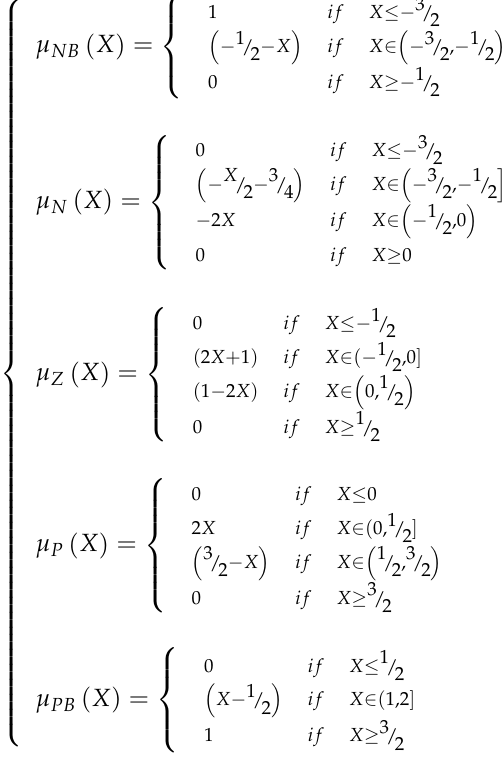
, and K (cid:48) i d